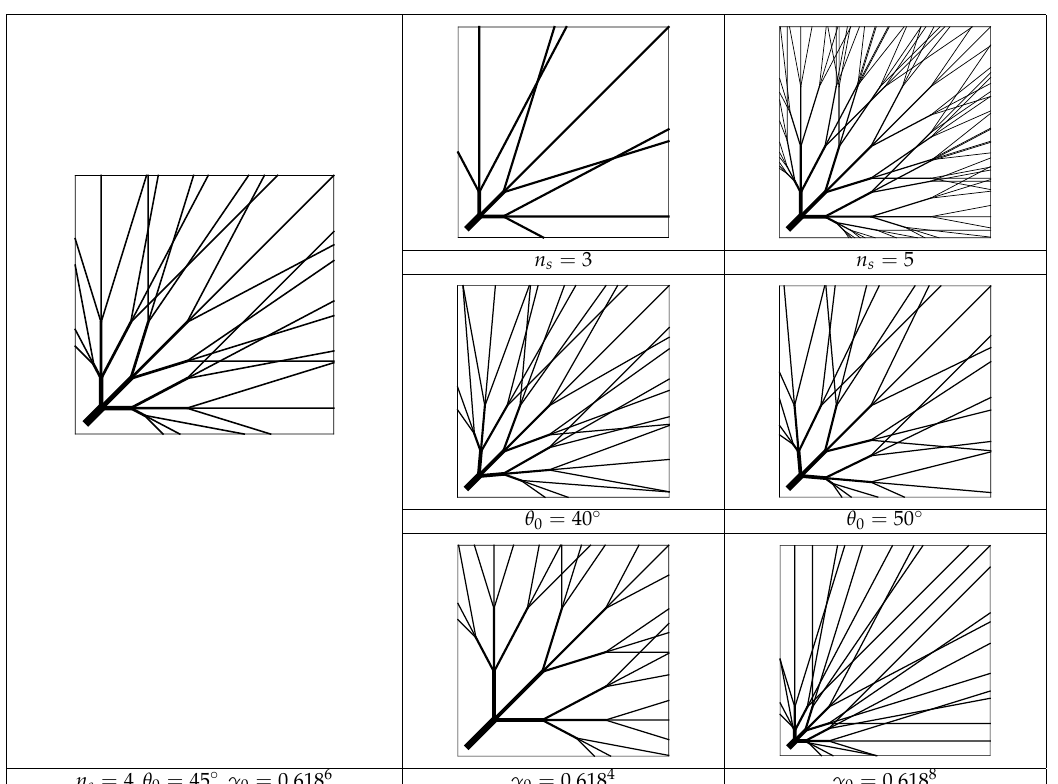
θ i 1 and θ i × − 1 and × −